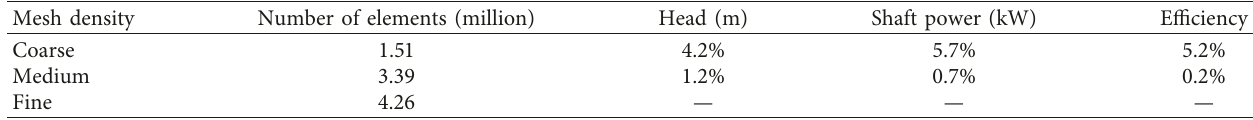
Table 4: Variation of the evaluation indexes.